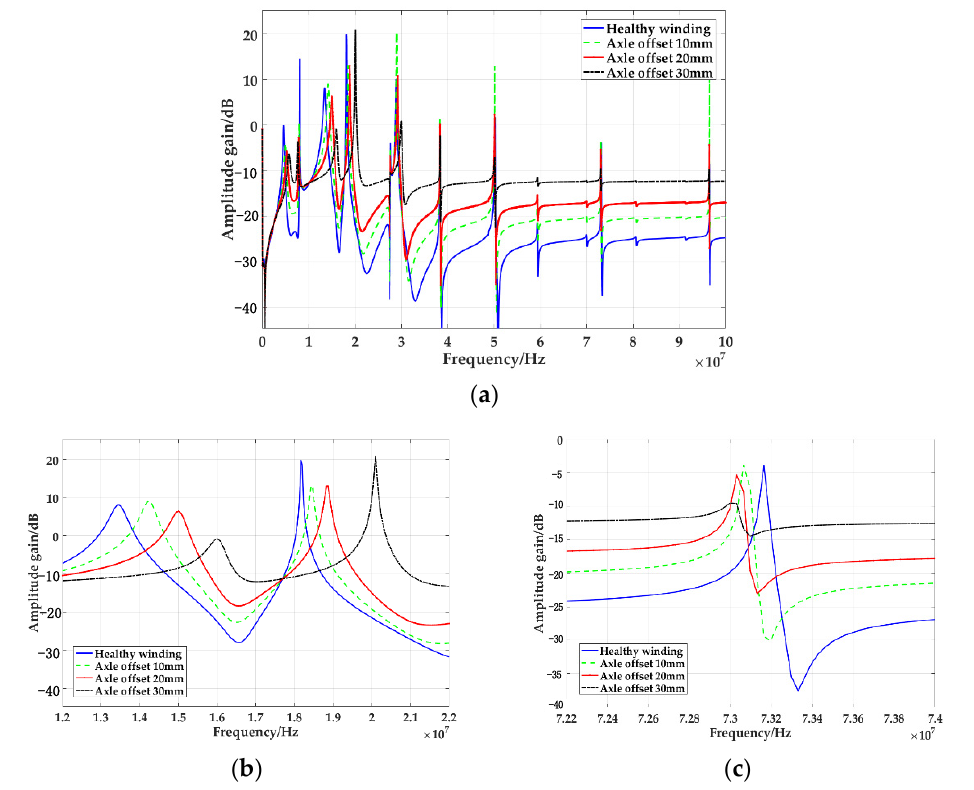
Figure 15. Frequency response curve of winding center offset: ( a ) full-band frequency response curve, ( b ) low-frequency partial amplification frequency response curve, and ( c ) high-frequency partial amplification frequency response curve.